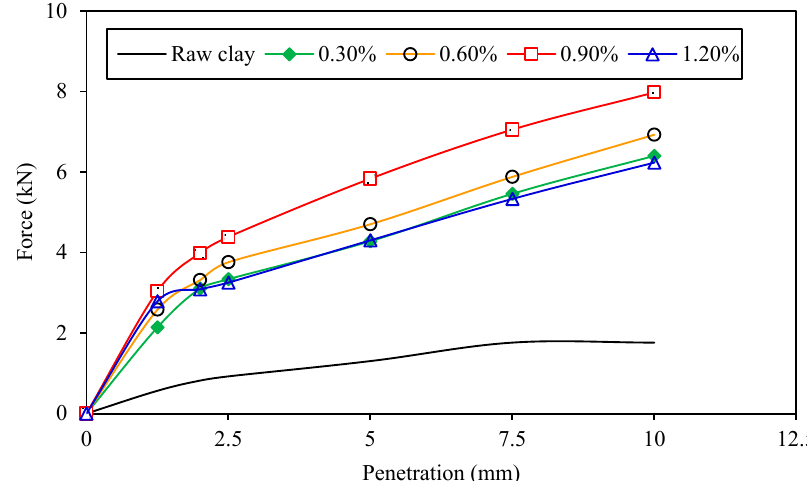
Figure 12. Load-penetration CBR curves for different fiber concentrations.